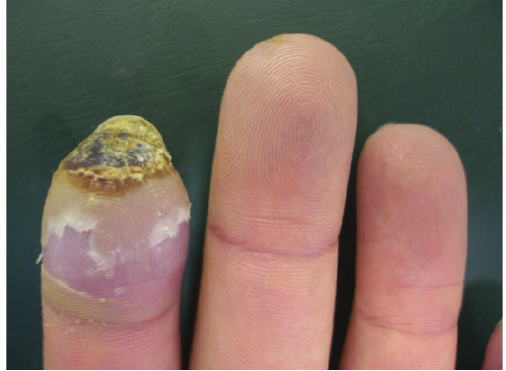
Figure 9: Systemic sclerosis.